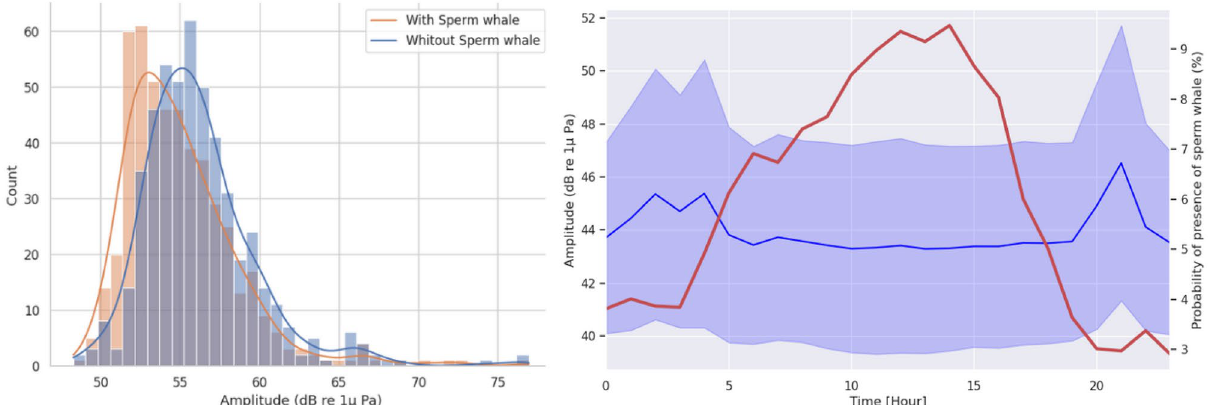
Figure 3. Left: Distribution of the amplitude for the octave 12,800 Hz according to presence/absence of sperm whales. Right: Superposition of dial pattern of amplitudes for the octave 12,800 Hz and probability of presence of sperm whales.